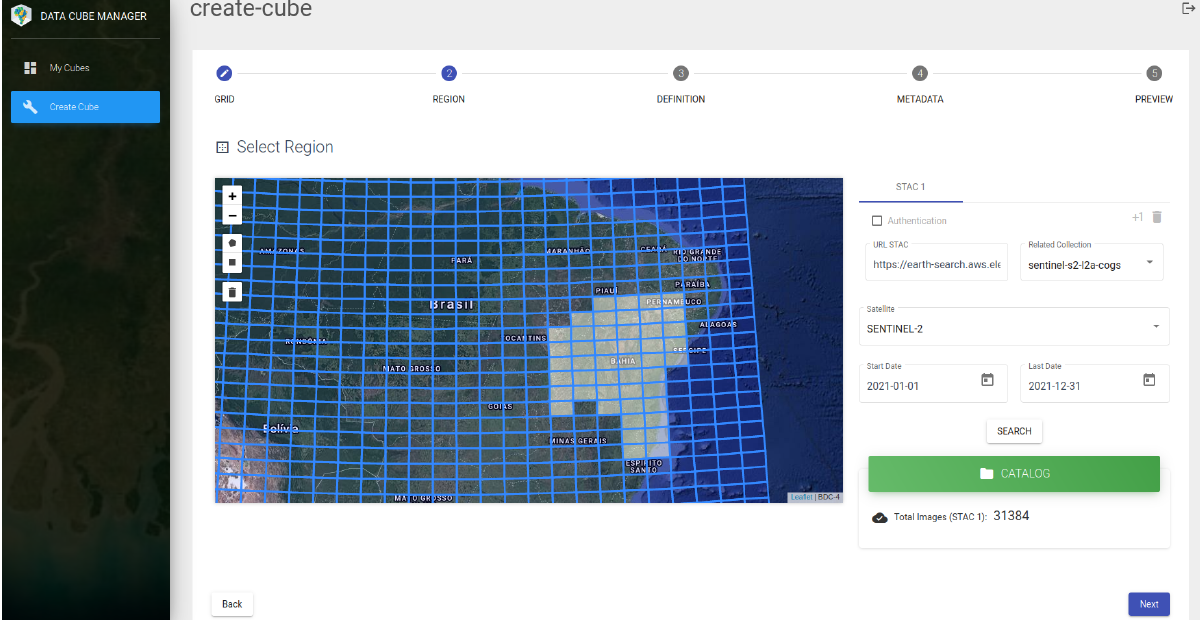
Figure 6. Graphical interface of Data Cube Builder on AWS - Data Cube